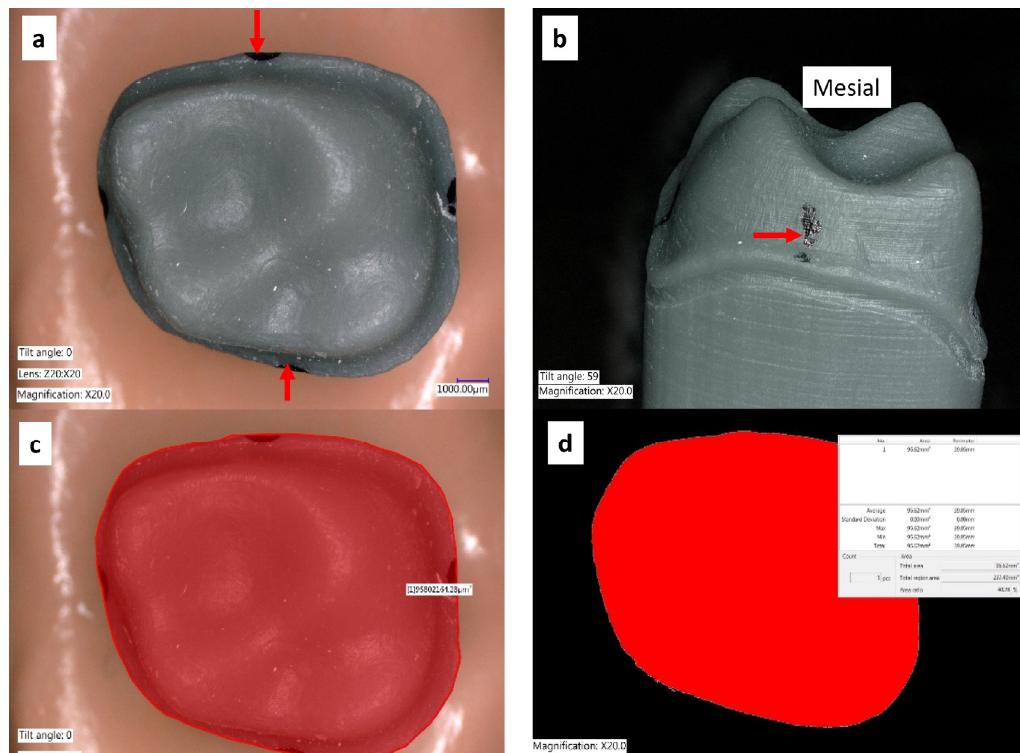
Figure 2. ( a ) Most prominent points of the die contours were marked. ( b ) A direct view of the mesial view showing the most prominent point. ( c ) The outline of the margin contour observed from an occlusal (top) view was traced ( d ) The area inside the margin was obtained and the surface area was calculated automatically by using the color difference detection function of the VHX-6000 microscope software.